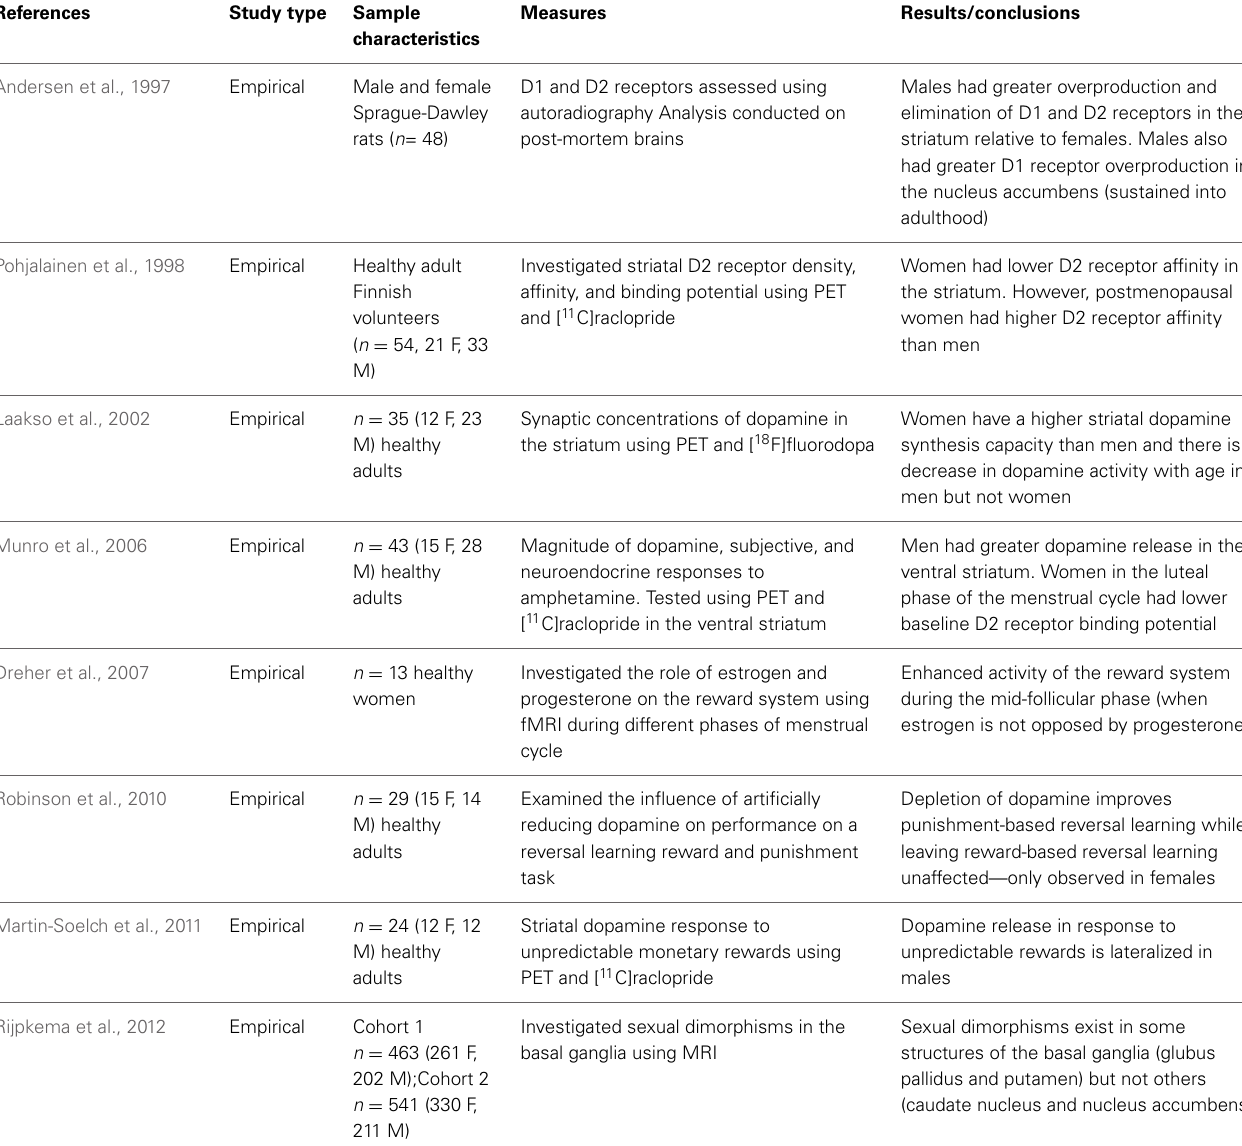
Table 3 | Sexual dimorphisms in the